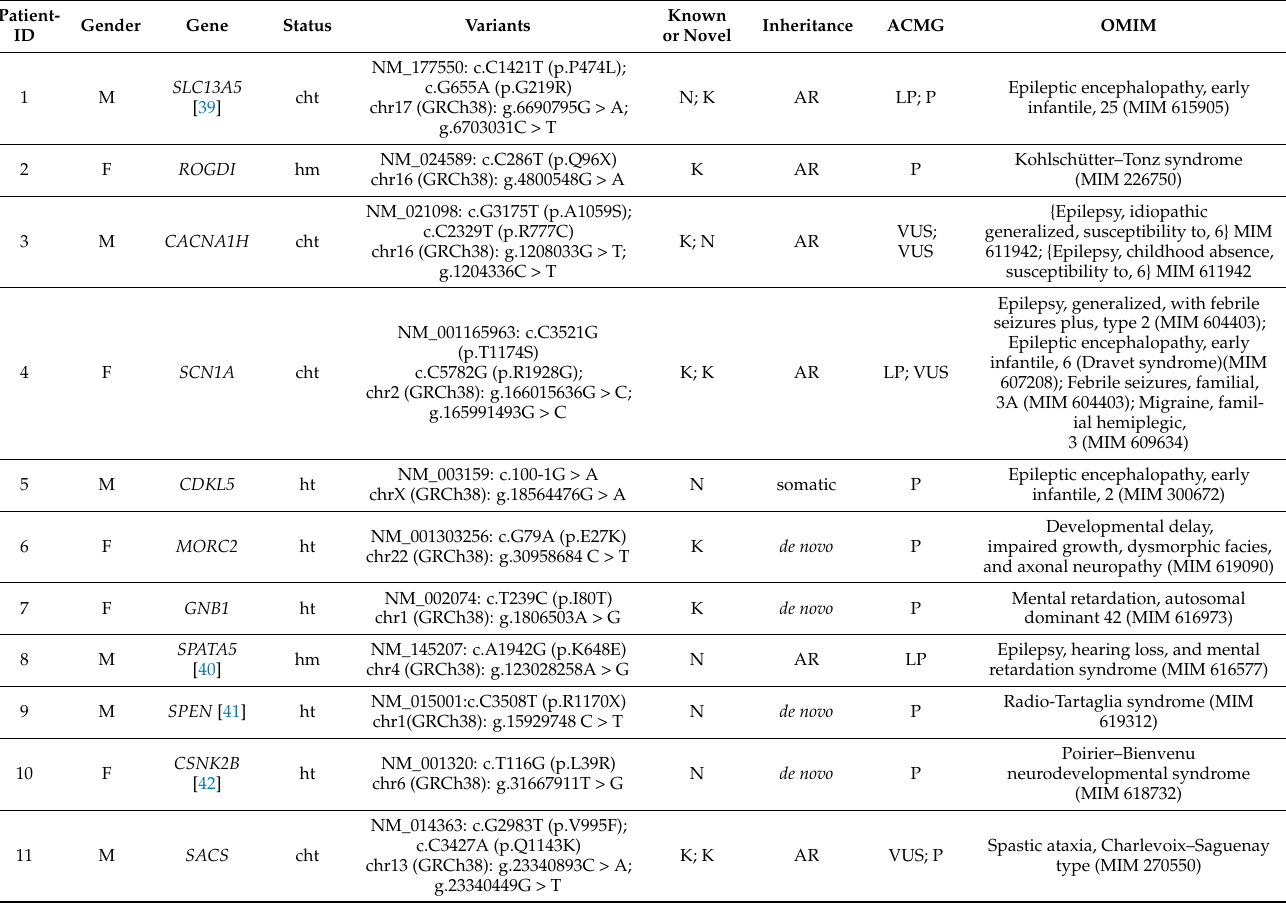
Table 4. Definite genetic diagnosis (patients 1–10) or possible diagnosis (patient